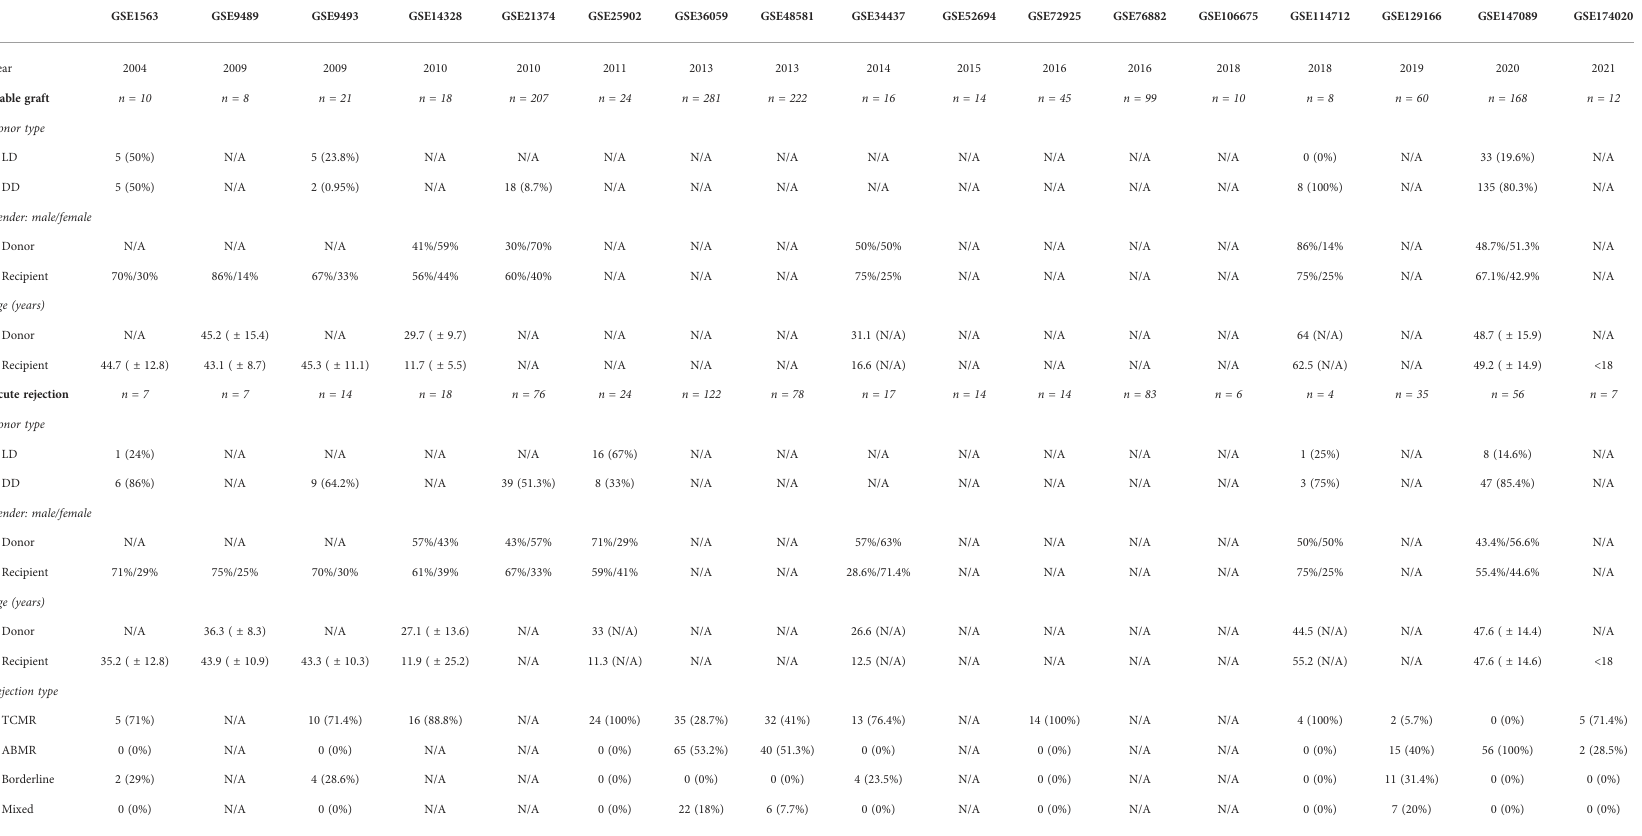
Dataset individual description relative to published year, platform, rejection type, and respective sample number for each group. LD, live donor; DD, deceased donor; TCMR, T cell-mediated rejection; ABMR, antibody-mediated rejection; N/A, Not